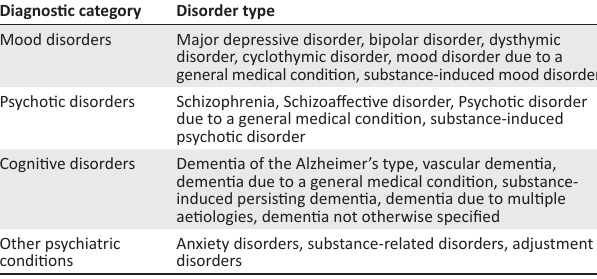
TABLE 1: Major categories used for diagnosis of psychiatric disorders according to the Diagnostic and Statistical Manual of Mental Disorders 4th edition, text